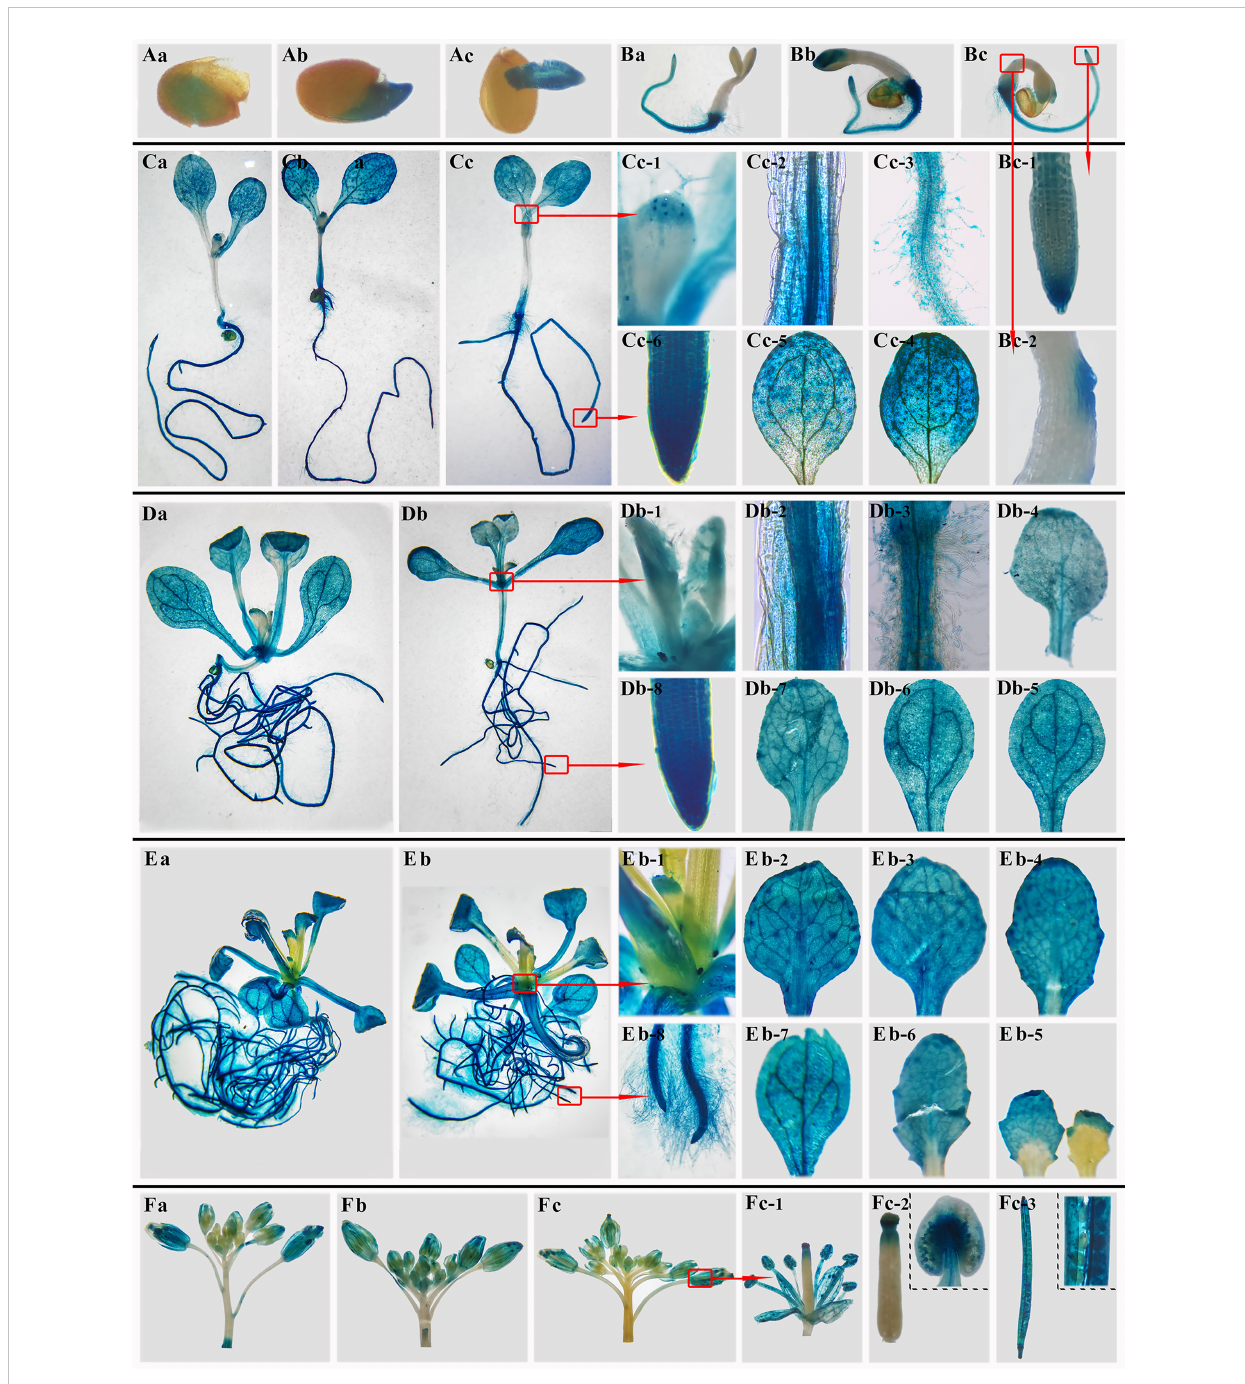
FIGURE 2 GUS staining of pCAMBIA1301- BoTCP25pro -GUS Arabidopsis plants at different stages. (A) Germinated seeds. (B) 3-day-old seedlings. (C) 5-day- old seedlings. (D) 10-day-old seedlings. (E) 15-day-old seedlings. (F) 35-day-old seedlings. Lowercase letters (a, b, c) refer to the three independent repeats of each stage. For (D) and (E) , two repeats were